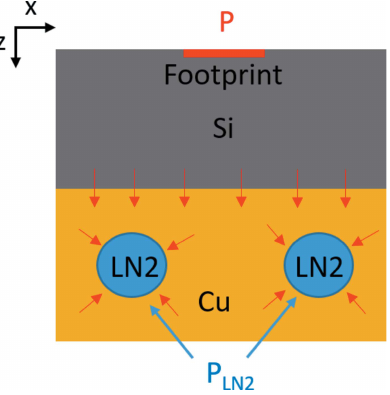
Figure 1 Schematic view of the indirect cryo-cooled monochromator. The red arrows show heat flow from the crystal to the cooling LN2